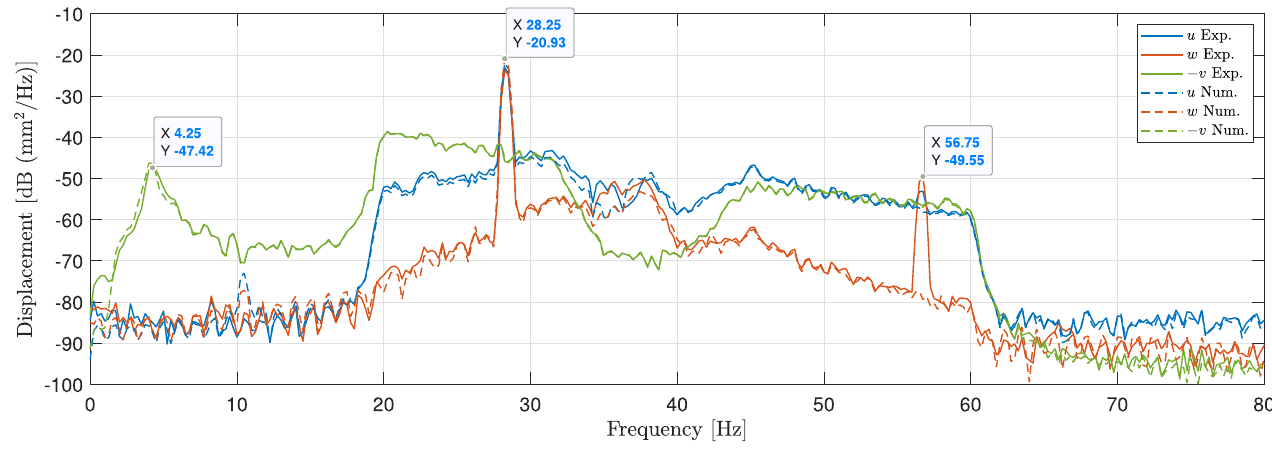
Fig. 9. PSD of the time-history responses of Figure 8 computed for t ∈ [5; 19]